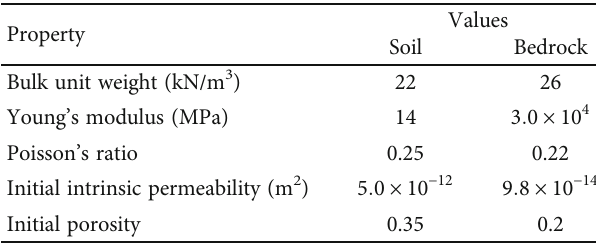
Figure 4: Geological pro fi les of section A-A ’ of the Tanjiawan landslide. Table 2: Material parameters of the Tanjiawan landslide.